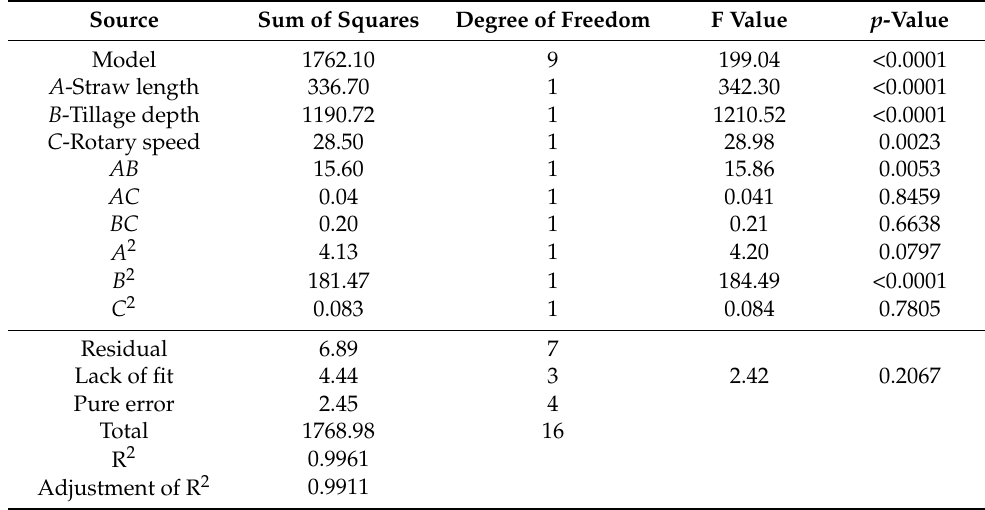
Table 5. Variance analysis of straw burial